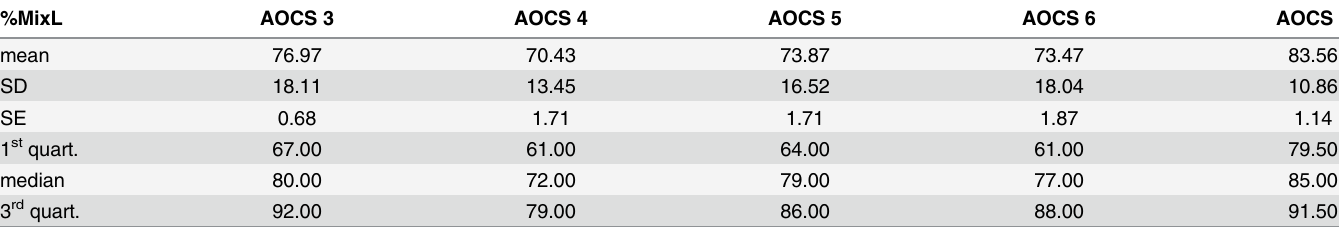
Table 3. Average time spent within the mixed surface layer by oceanic whitetip sharks tagged in the western Atlantic